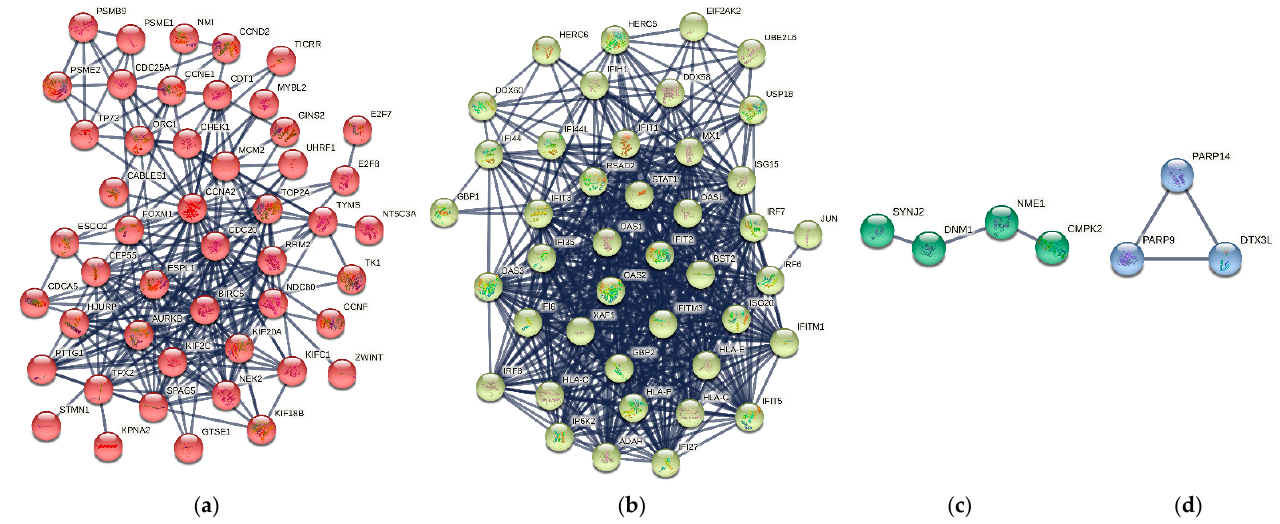
Figure 6. Module detection from the IPIN using MCL algorithm in STRING v11.0. Circles with different colors represent proteins in different clusters. ( a ) MCL1 had 48 nodes (marked as red) and 234 edges. ( b ) MCL2 had 42 nodes (marked as yellow) and 528 edges. ( c ) MCL3 had 4 nodes (marked as green) and 3 edges. ( d ) MCL4 had 3 nodes (marked as blue) and 3 edges.